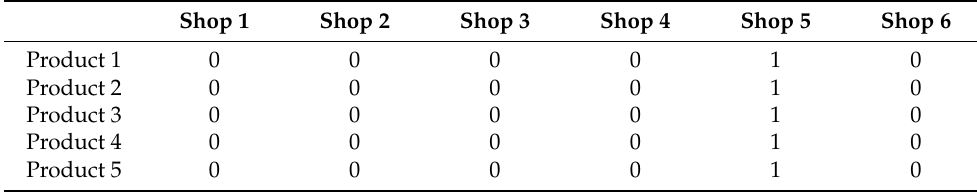
Table 11. The result of numerical solution (products).